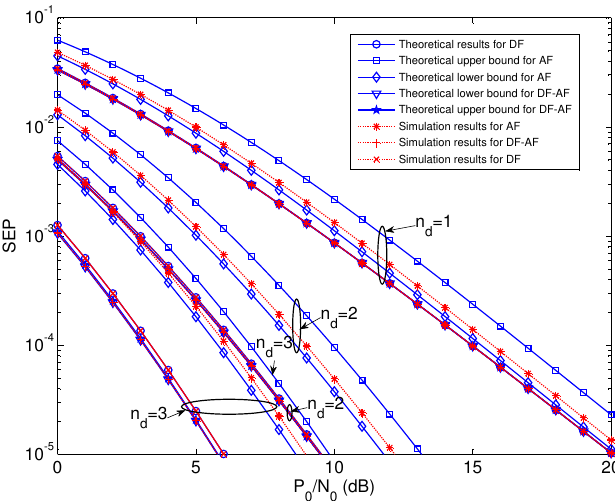
code when all fading 3